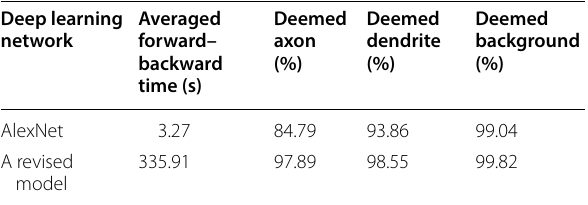
Table 4 Comparison of AlexNet with a revised